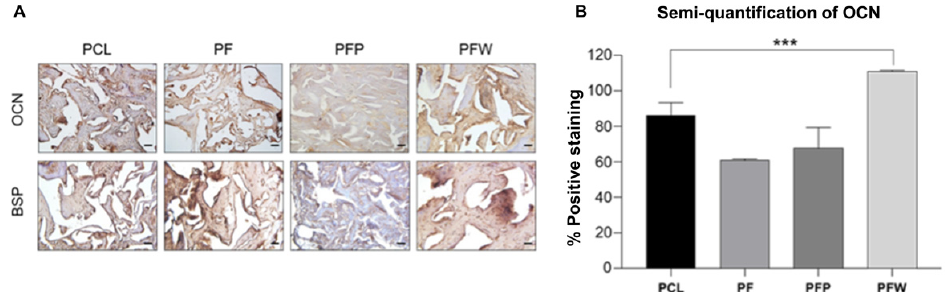
Figure 6. New bone formation of engineered PCL scaffolds at 7 months of implantation. ( A ) Immunohistochemical staining of osteocalcin and bone sialoprotein (DAB-hematoxylin, bright field) and ( B ) semi-quantification of OCN expression measured by ImageJ software. PCL group: PCL 300 mg c 20 wt% neither fat nor blood products ( n = 4); PF (PCL + fat) group: PCL 300 mg c 20 wt% and fat 50 mg ( n = 4); PFP (PCL + fat + PRP) group: PCL 300 mg 20 wt%, fat 50 mg, and PRP 50 µL ( n = 2); PFW (PCL + fat + WP) group: PCL 300 mg c 20 wt%, fat 50 mg, and WP 50 µL ( n = 4)), scale bar: 50 µm, magnification: ×200, *** p < 0.005 by ANOVA and post hoc tests.